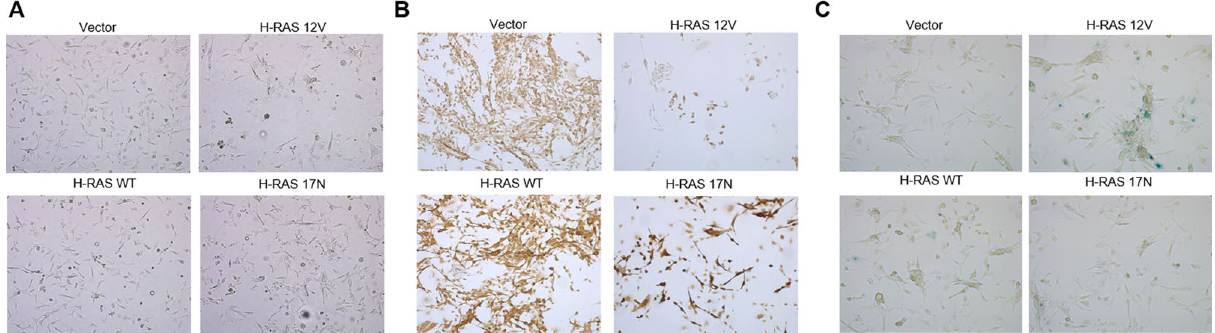
Figure 7. Analysis of morphologic and phenotypic changes of RMS-YM cells in response to ectopic RAS expression. ( A ) Expression of H-RAS constructs did not induce significant morphology changes as observed under light microscopy, despite slow growth kinetics. ( B ) To assess for markers of differentiation, RMS-YM cells expressing H-RAS mutants were cultured in differentiation media and stained for the myogenic marker sarcomere myosin using the anti-sarcomere-myosin hybridoma MF20. Representative images are shown. Cells expressing oncogenic H-RAS are not viable after multiple days in low serum conditions whereas cells expressing dominant negative H-RAS have become elongated and show increased staining. ( C ) To assess senescence, RMS-YM cells expressing H-RAS mutants were stained for β-gal. Representative images are shown. Expression of oncogenic H-RAS increased β-gal staining (blue color) whereas the other H-RAS mutants did